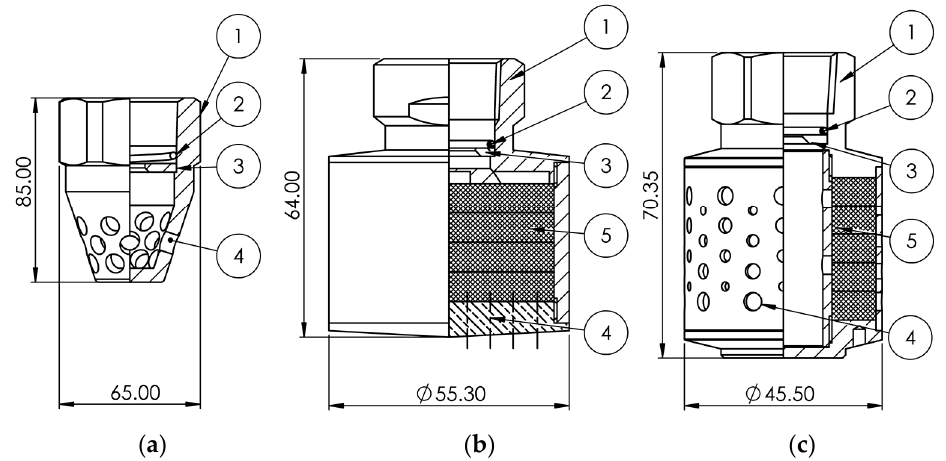
Figure 4. Technical sketch of the employed nozzles, with values provided referring to the orifice diameter: ( a ) standard; ( b ) silent; ( c ) silent for low ceiling applications; the marked components are ( 1 ) nozzle body; ( 2 ) spring; ( 3 ) orifice; ( 4 ) holes; ( 5 ) sound-absorbing layer.